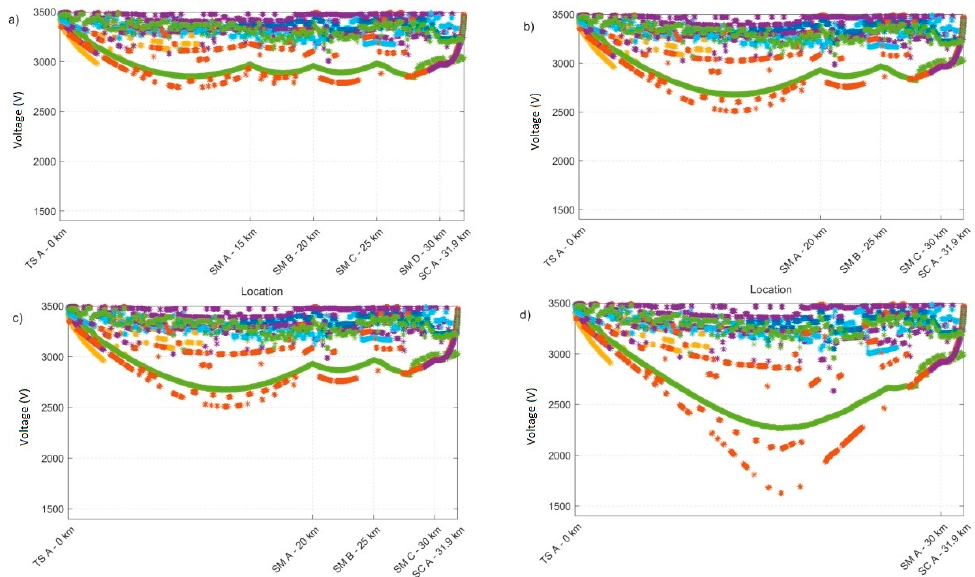
Figure 7. The pantograph voltage 1-s values for a train operating in an analyzed traction power infrastructure, ( a ) distributed power supply system, 4 SMs located in 15, 20, 25 and 30 km ( b ) distributed power supply system, 3 SMs located in 20, 25 and 30 km ( c ) distributed power supply system, 2 SMs located in 20 and 30 km, and ( d ) distributed power supply system with single SM located in 30 km.